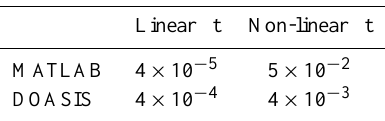
Table 3. Computation times for linear and non-linear fits from MATLAB and DOASIS in seconds per